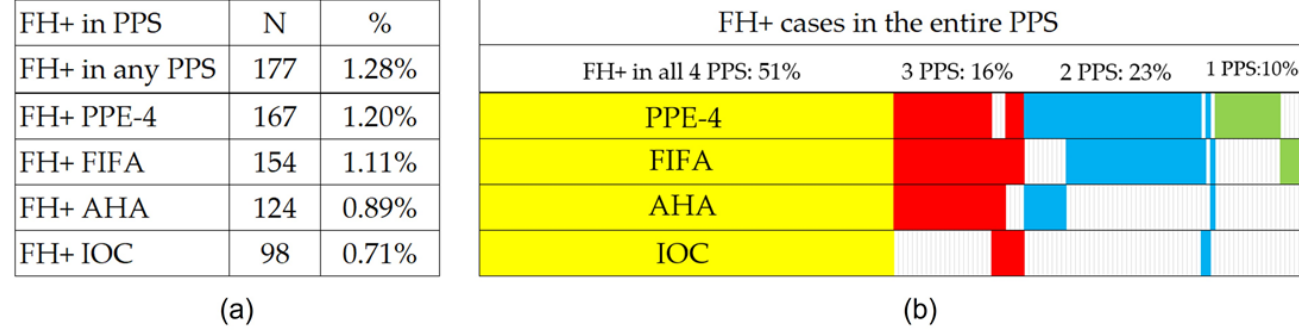
Figure 1. Prevalence of positive family history in the PPS systems: ( a ) this figure shows the overall prevalence (in numbers and percentages) of positive family history in each of the four PPS systems in separate rows (PPE-4, FIFA, AHA, IOC); ( b ) this figure shows the combined prevalence rate in all four systems, three systems, two systems, and one system. Rectangles of different colors represent the distribution of cases with a positive family history in each PPS system.